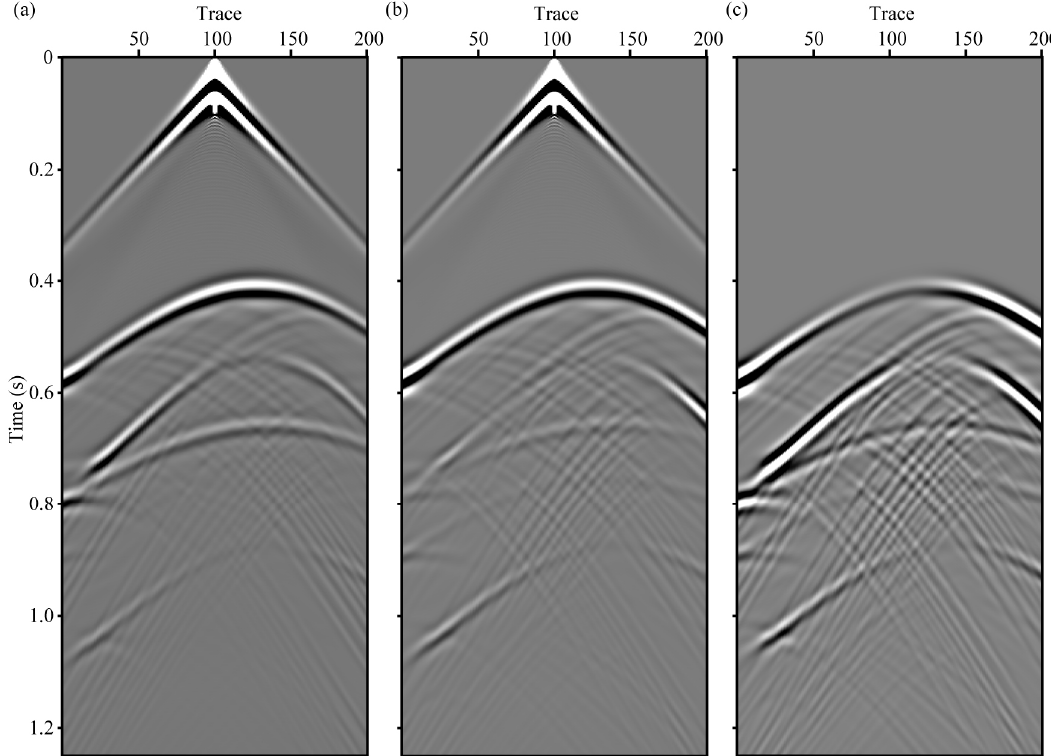
Figure 8. Comparison of Z-component waveforms in line 1 with and without the shale anisotropy (TTI model). ( a ) is the Z-component wavefield of model M 0 (without anisotropy), ( b ) is the Z-component wavefield of model M ED (with anisotropy), and ( c ) is the residual wavefield for ( a ) and ( b ).